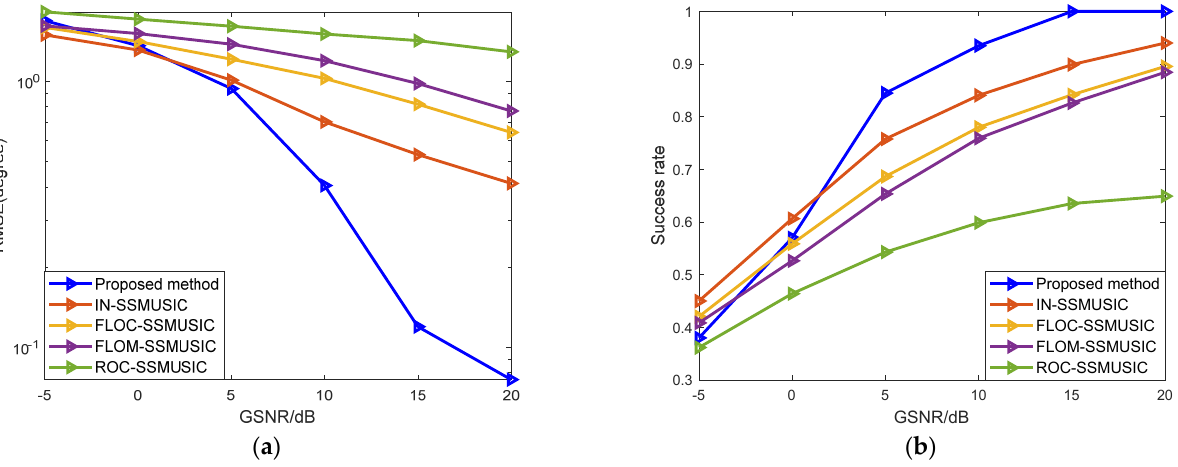
Figure 5. Analysis of the mean square error and success rate of the algorithm under noise: ( a ) Rela- tionship between RMSE and GSNR; ( b ) Relationship between success rate and GSNR.